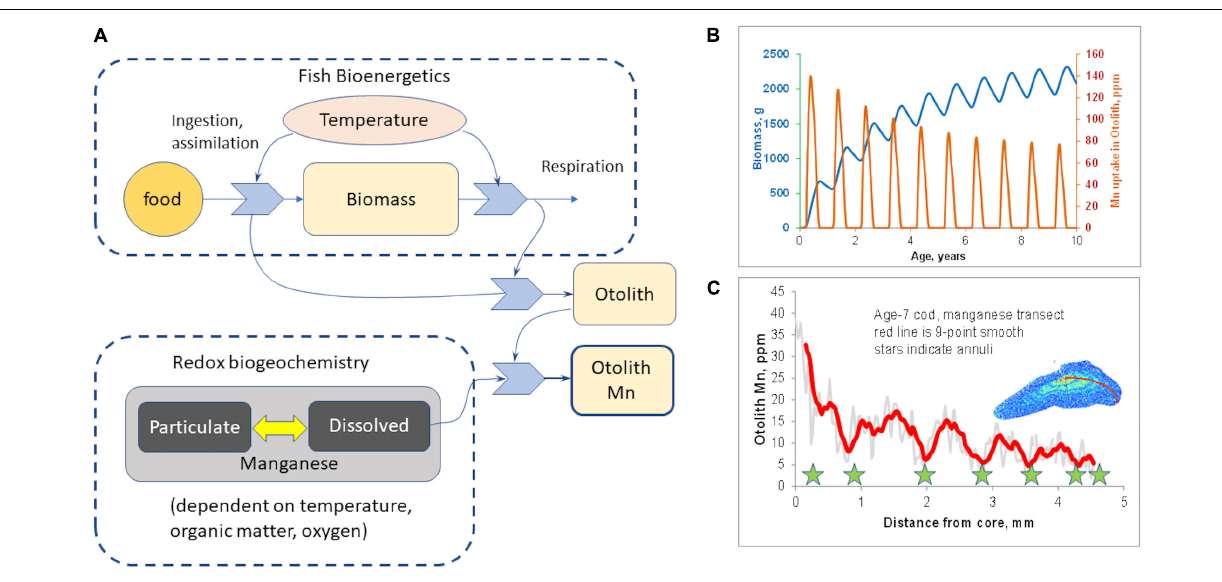
FIGURE 2 | Hypothesized mechanism of otolith manganese incorporation. (A) Schematic of conceptual model postulating mechanism of manganese incorporation into otoliths (see Supplementary Information for model details). Otolith Mn is a function both of fish growth and of availability of dissolved Mn (i.e., reduced Mn 2 + ). (B) Model output, simulating 10 years of growth where seasonal biogeochemistry is identical every year, but otolith Mn declines due to decrease in fish growth. (C) Otolith Mn in a 7-year-old Baltic cod, showing similar seasonal increases in summer, but overall decline due to natural decrease in growth with